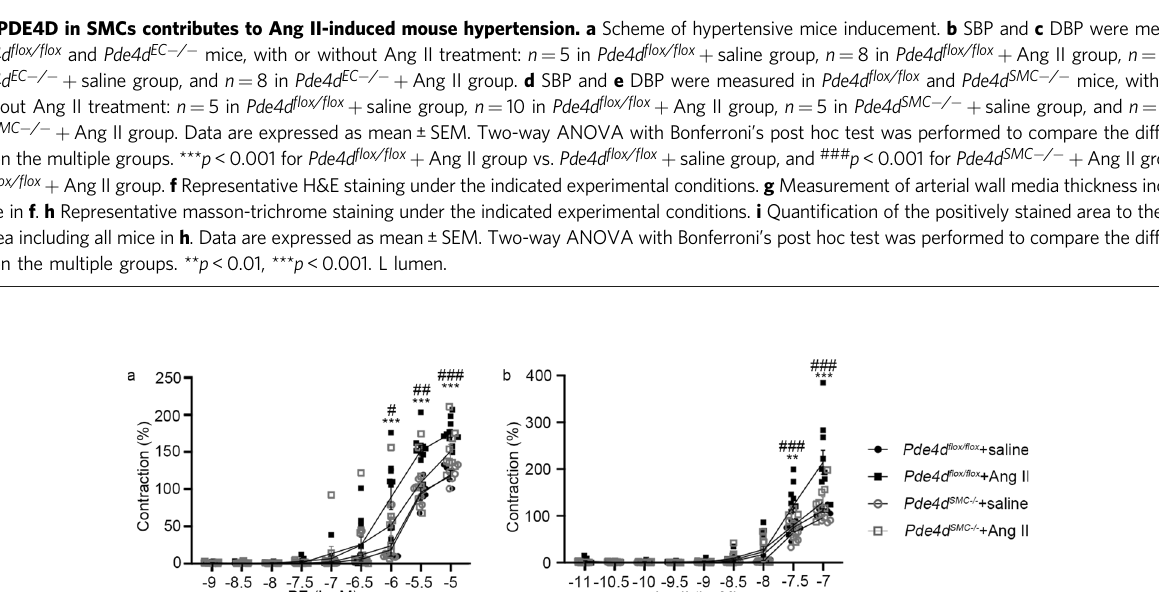
Fig. 2 PDE4D in SMCs contributes to Ang II-induced mouse hypertension. a Scheme of hypertensive mice inducement. b SBP and c DBP were measured in Pde4d fl ox/ fl ox and Pde4d EC − / − mice, with or without Ang II treatment: n = 5 in Pde4d fl ox/ fl ox + saline group, n = 8 in Pde4d fl ox/ fl ox + Ang II group, n = 5 in Pde4d EC − / − + saline group, and n = 8 in Pde4d EC − / − + Ang II group. d SBP and e DBP were measured in Pde4d fl ox/ fl ox and Pde4d SMC − / − mice, with